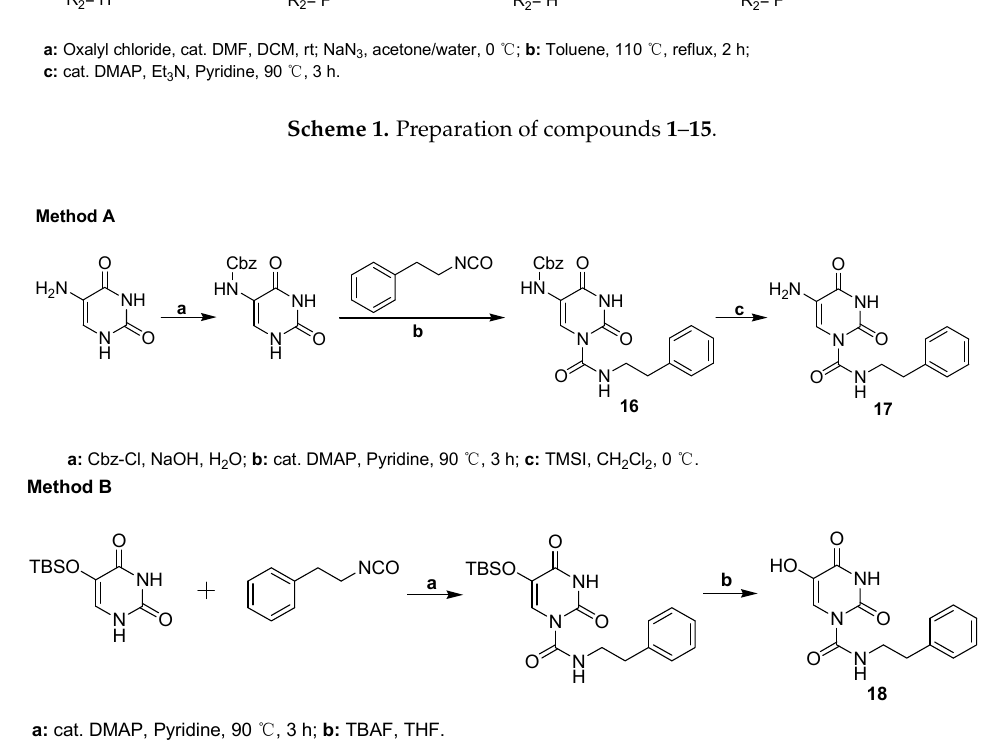
Scheme 2. Preparation of compounds 16 – 18 .